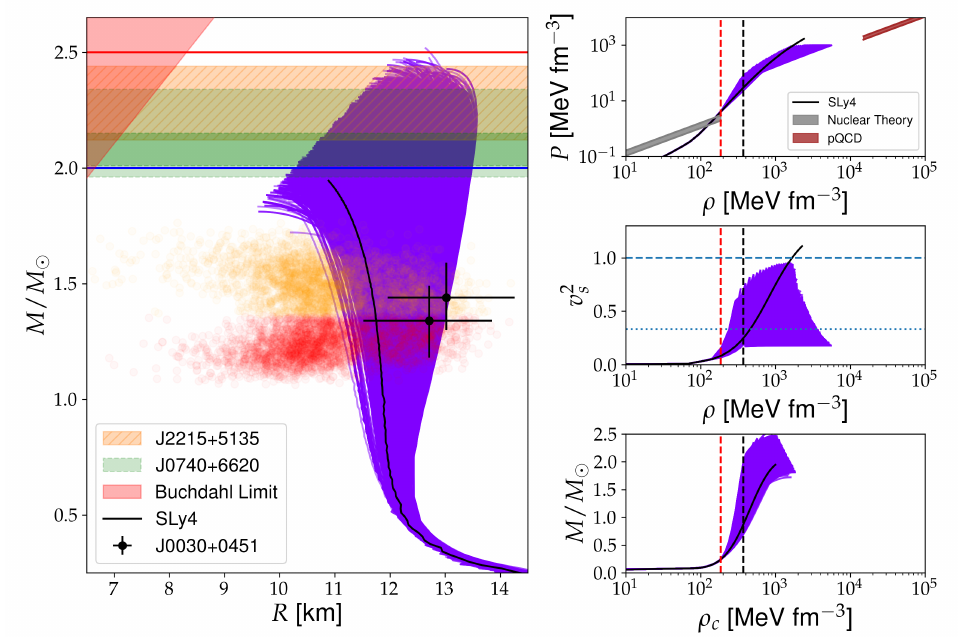
Figure 4. On the left side: Mass–radius relationship for the MD1 parametrization from Table 1. The blue continuous line at 2.0 M corresponds to the two massive pulsars J0348+0432 and J1614-2230. (cid:12) The filled green region represents the pulsar J0740+6620 and the filled dashed salmon region is the pulsar J2215+5135. The red line is the low mass compact object in the binary system GW190414. The dark dots with errors bars are the NICER estimations of PSR J0030+0451. The purple curves in the left panel are the mass–radius relationships for the EoS generated by the MCMC algorithm. In the upper right corner, in purple, we have the MD1 EoS generated by the algorithm. In the middle right panel, we have the sound speed, and, in the lower panel, the masses for different central densities. The two vertical lines represent the transition regions, and the dashed-dotted horizontal lines in the middle right panel are the luminal and conformal velocities. Dark lines represent the SLy4